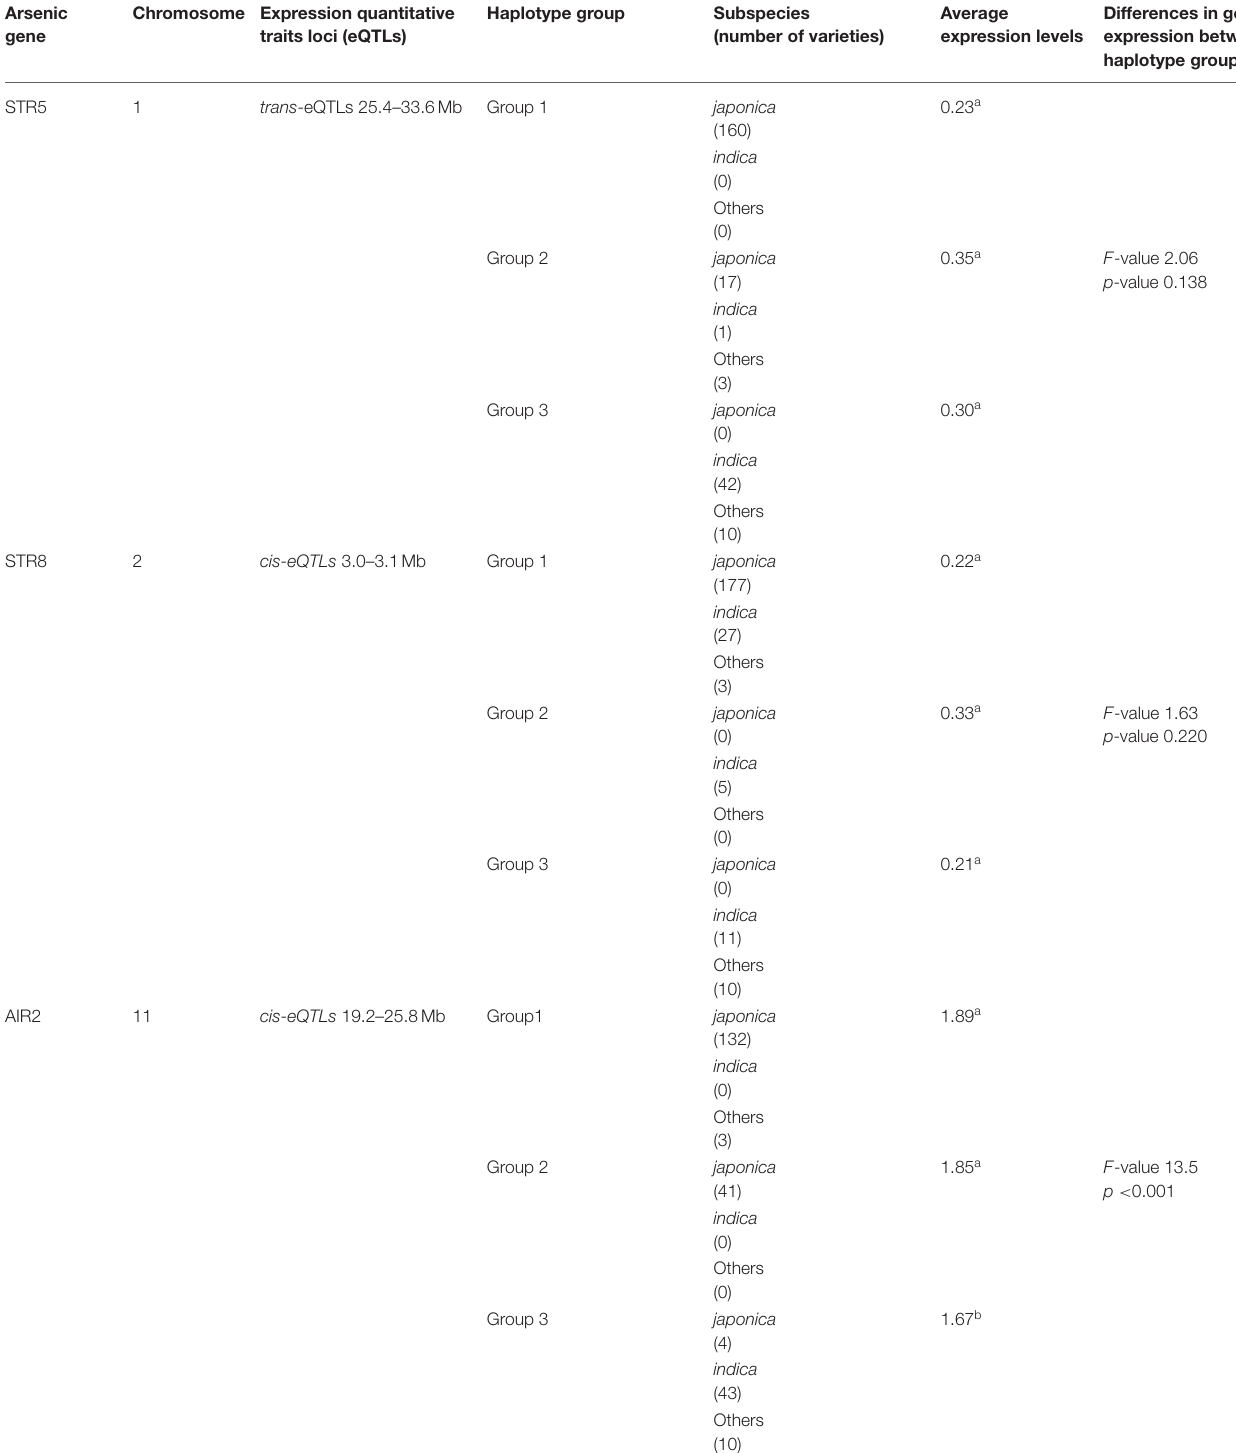
a and b indicates whether there is a statistically significant difference between